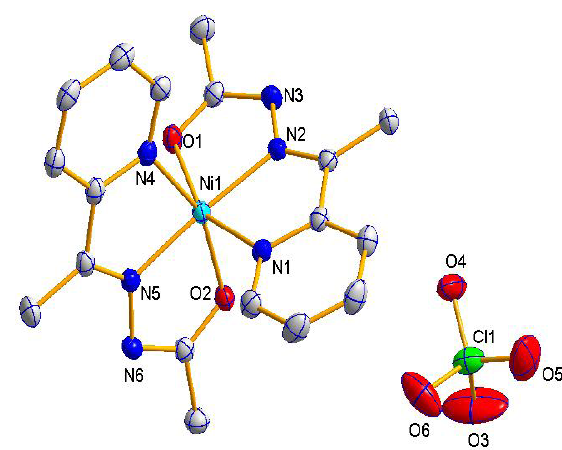
Figure 2. An ORTEP plot of complex 2 . Ellipsoids are drawn from 30% probability label. Hydrogen atoms are omitted for clarity.